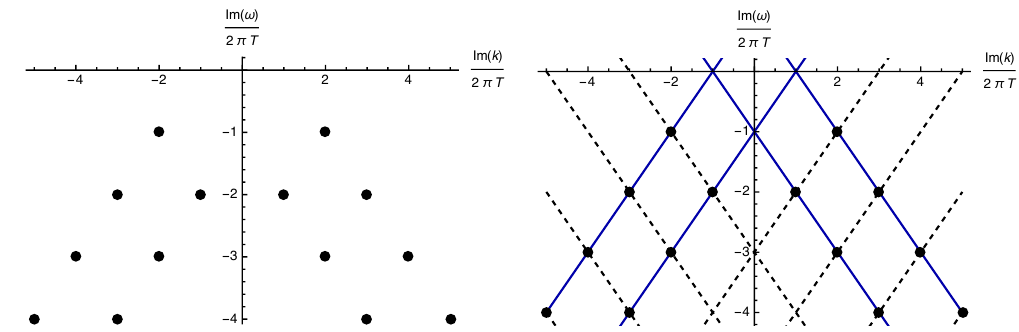
Figure 4 . The left hand plot shows the pole-skipping locations (C.1) predicted from our near horizon analysis for (cid:1) = 3 and n = 1 ; 2 ; 3 ; 4. The right hand plots shows the lines of zeroes (blue) and poles (dashed) in the (cid:1) = 3 Green’s function (C.8). The intersections of these lines give rise to min(2 n; 2(cid:1) (cid:0) 2) instances of pole skipping at frequencies ! n = (cid:0) i 2 (cid:25)Tn